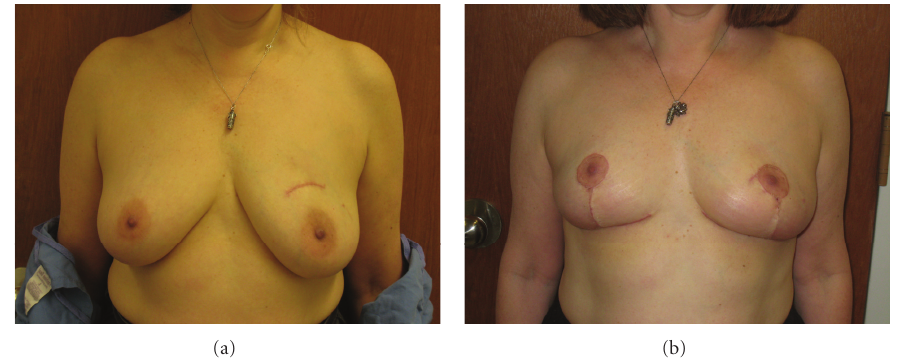
Figure 2: (a) Preoperative appearance of patient with left breast cancer. (b) Two-month postoperative appearance of patient after inferior pedicle Wise pattern breast reduction. Note incorporation of lumpectomy scar over superomedially located tumor into the incision for the